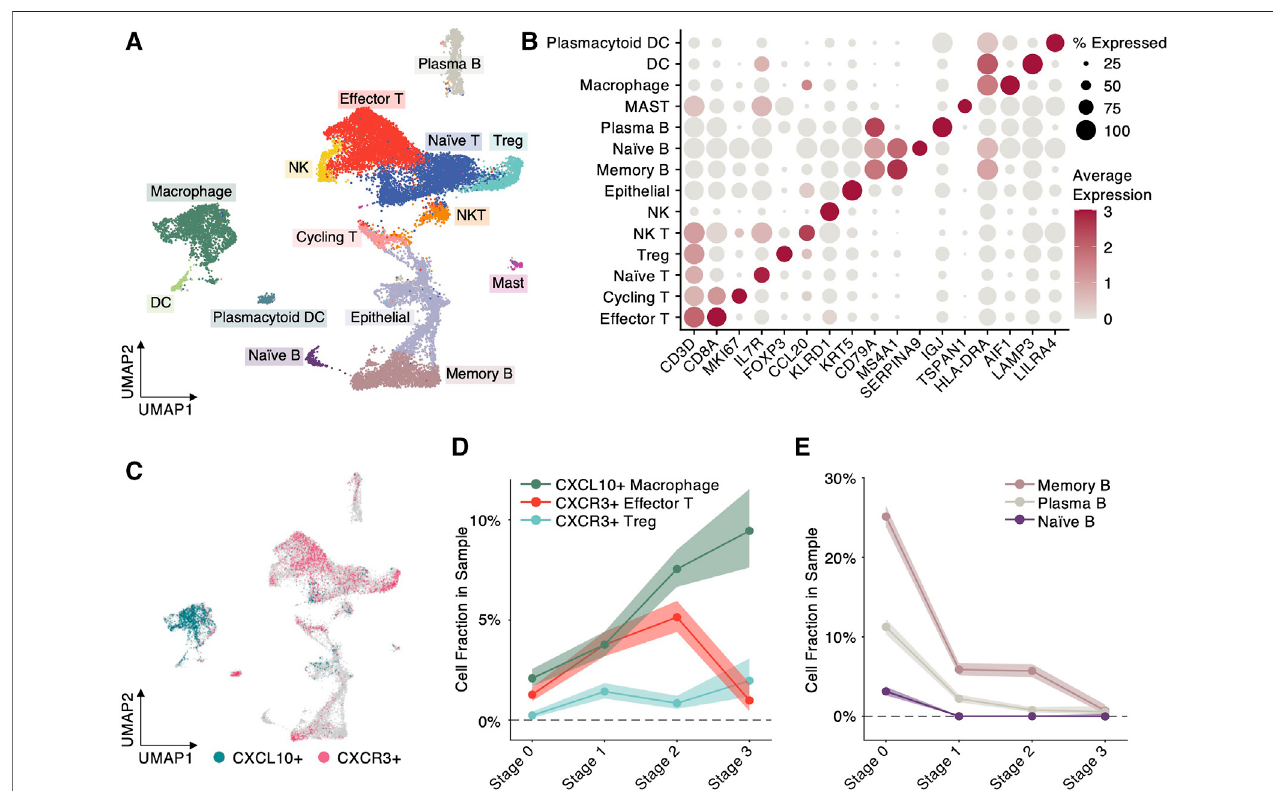
FIGURE 3 | Single-cell RNA sequencing analysis uncovers cellular origin of progression-associated modulators. (A) Scatter plot of each cell at 2D UMAP space. Colors denote different cell types. (B) Scatter plot of average expression of biomarker genes in different cell types. Color intensity denotes expression level and dot size denotes percentage ofcells expressing thebiomarker. (C) Scatter plotofeach cell at2DUMAP space.Colorsspecifythe cellshighly expressing CXCL10 orits receptor CXCR3 (normalized expression > 2). (D) Cell fractions, de fi ned by the cell number highly expressing CXCL10 or CXCR3 divided by the total cell number in the cell type, at different NPC progression stages. Shaded area indicates 99% Con fi dence Interval. (E) B-cell fractions, de fi ned by the B cell numbers divided by the total cell number in the sample, at different NPC progression stages. Shaded area indicates 99% Con fi dence Interval.